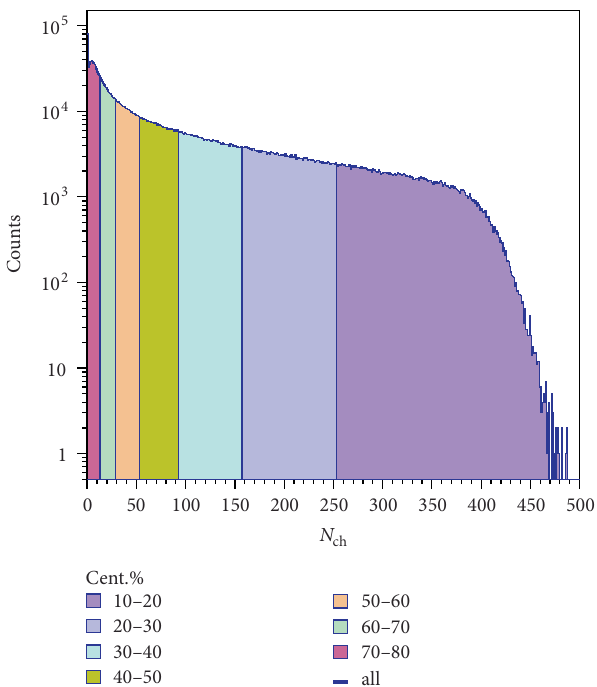
Figure 1: An example of centrality selection from the multiplicity distribution of minimum bias simulated events at 𝐸 lab = 40A GeV.